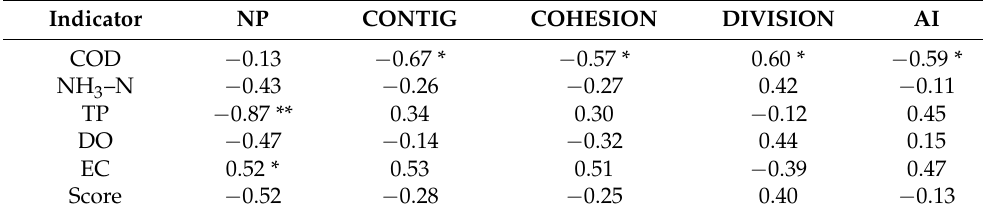
Table 4. Correlations between landscape configuration indices of forest land and surface water quality indicators (200 m